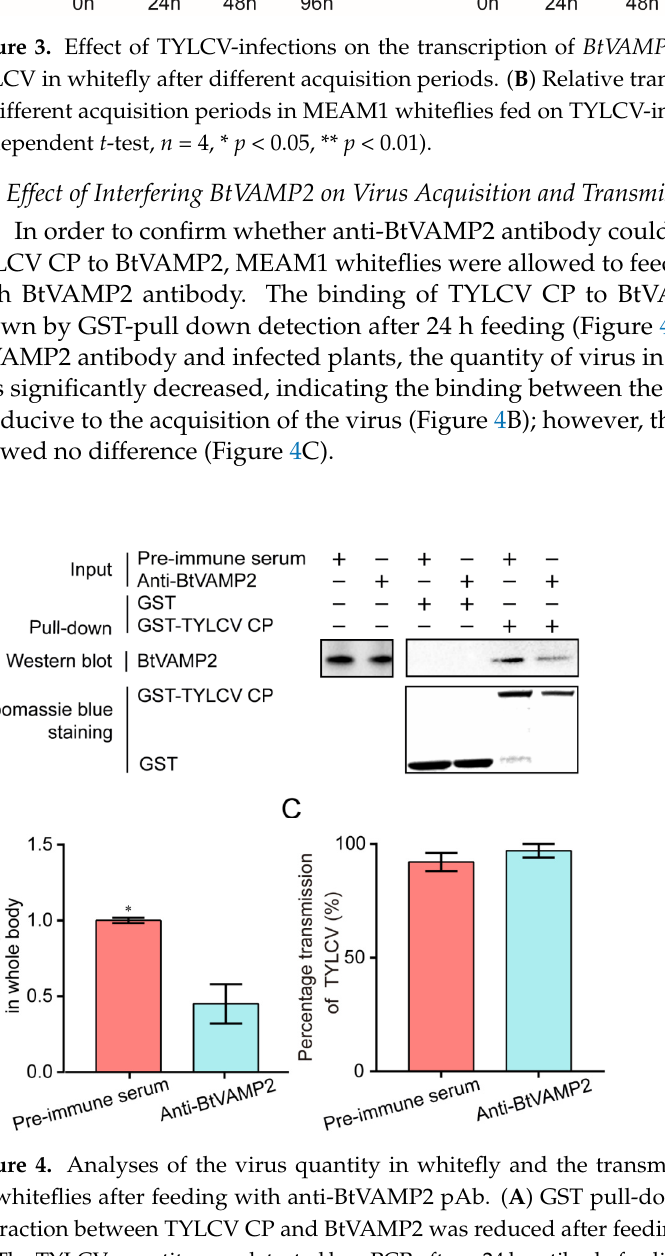
Figure 3. Effect of TYLCV-infections on the transcription of BtVAMP2 . ( A ) Relative quantity of TYLCV in whitefly after different acquisition periods. ( B ) Relative transcription level of BtVAMP2 at different acquisition periods in MEAM1 whiteflies fed on TYLCV-infected or uninfected plants (independent t -test, n = 4, * p < 0.05, ** p < 0.01).